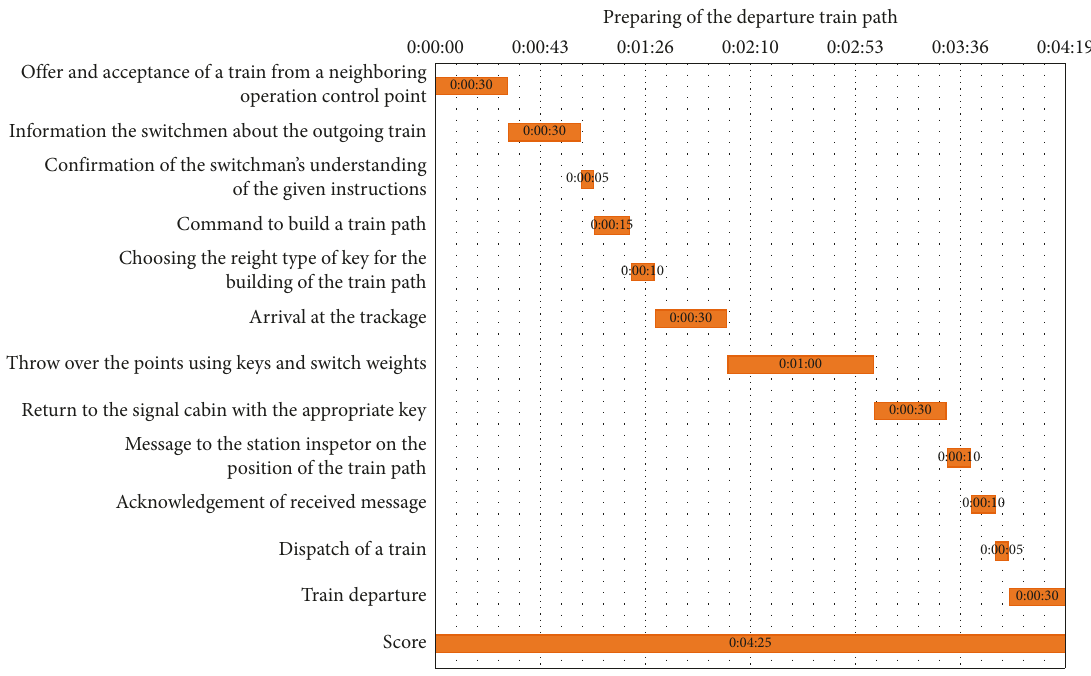
Figure 4: Preparing the departure train path on the mechanical interlocking